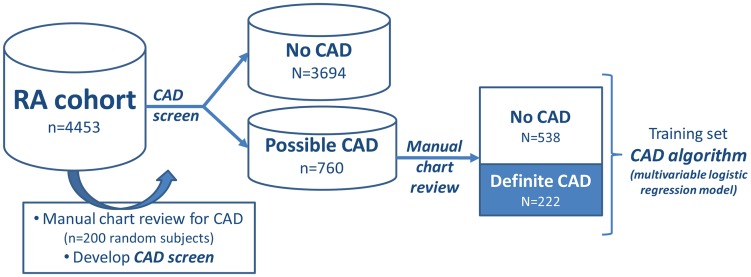
Overview of approach to developing the CAD algorithm in the RA cohort.